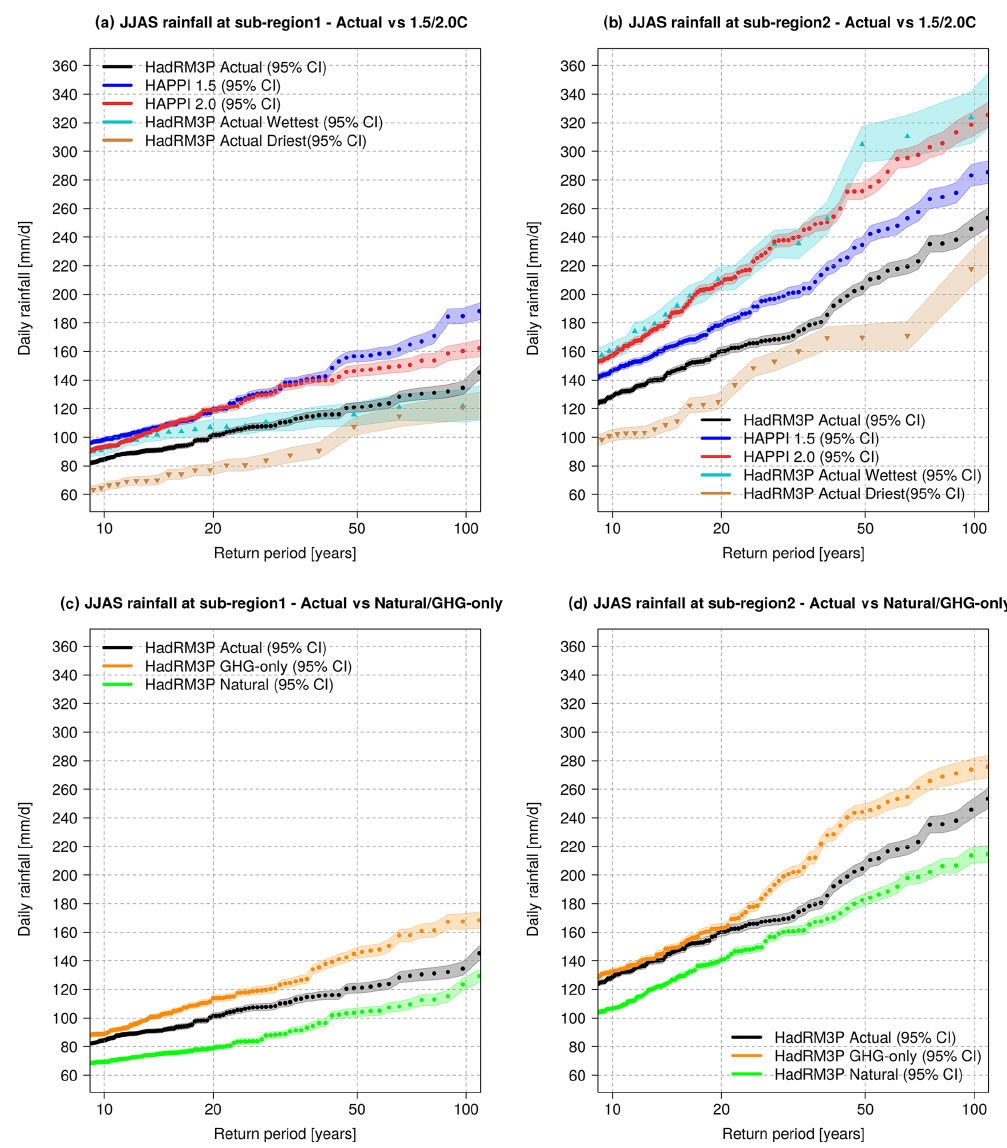
Figure 8. Return time plots for daily rainfall during monsoon (JJAS) season in different forcing scenarios over the sub-regions of 1 and 2 of Bangladesh. The HadRM3P ACT (black), ACT highest (upper grey with upward triangles), ACT lowest (lower grey with downward triangles), NAT (green), and GHG-only (orange) ensembles are compared with the HAPPI 1.5 (blue) and HAPPI 2.0 (red)